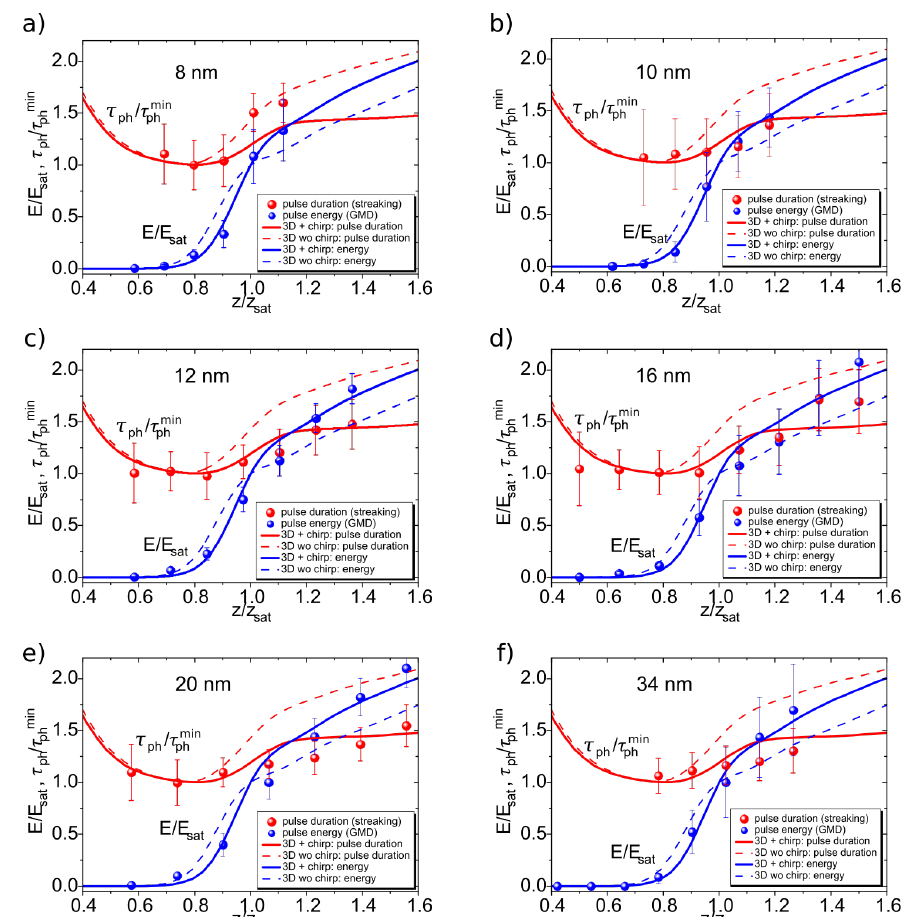
Figure 3. Evolution of the pulse duration (red circles) and pulse energy (blue circles) along the undulators. The actual undulator length z is normalized by the saturation length z sat . The pulse energy is normalized to the saturation energy and the pulse duration to the minimum pulse duration (Equation (4)). The experimental results (shown as points) represent the average over several thousand single pulse measurements and were recorded for FEL wavelengths of 8, 10, 12, 16, 20, and 34 nm and agree very well with the chirped 3D simulations (shown as red and blue solid lines). The 3D simulations without energy chirp (shown as red and blue dashed lines) are showing less agreement with the experimental data. The “error bars” denote not the experimental uncertainty but rather the width of the measured distribution induced by SASE and technical fluctuations to indicate by how much the FEL pulse energy and duration fluctuate during measurement (see also Figure